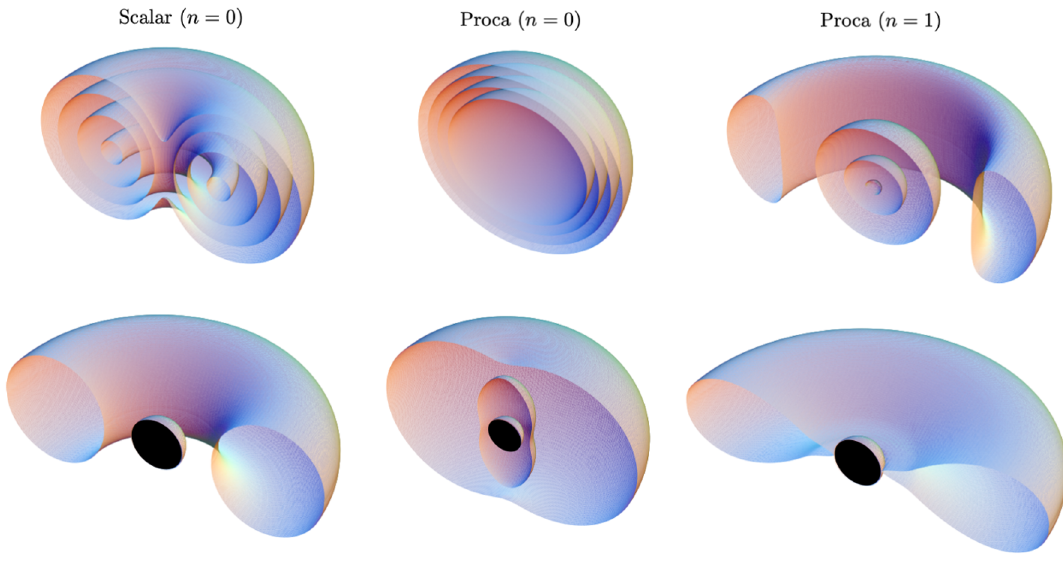
Figure 12 . Morphology of the surfaces of constant energy density of scalar ( n = 0) and vec- tor/Proca ( n = 0 and n = 1) spinning bosonic stars (top panels) and BHs with synchronised hair of the corresponding type (bottom panels). For the BHs, the black disk represents the horizon. All these solutions have m = 1. The hairy BHs bifurcate from clouds with ‘ = 0. Besides further